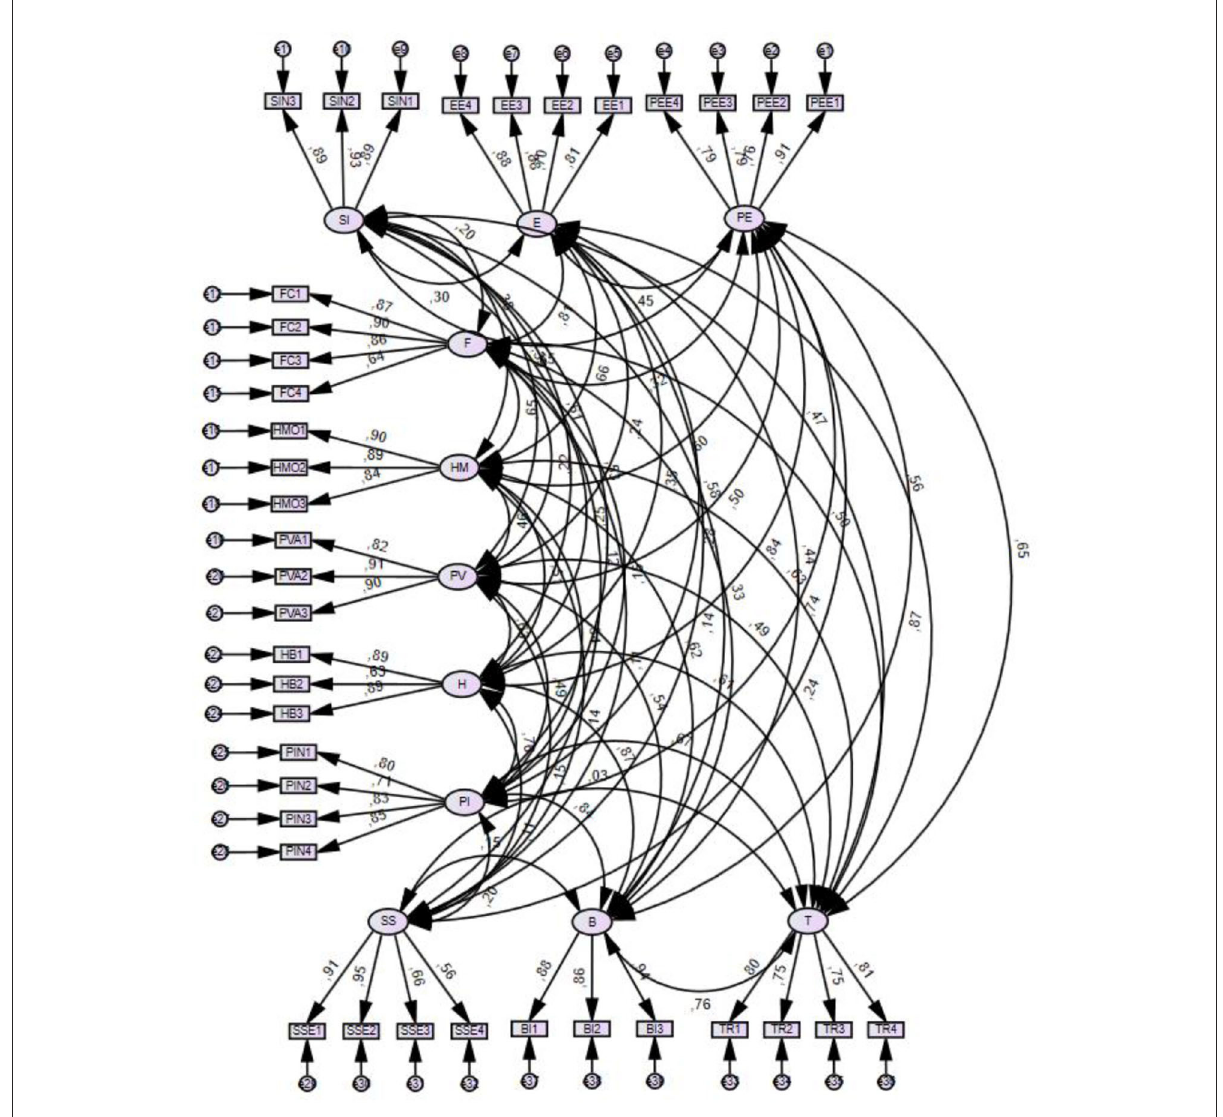
FIGURE2 Measurement